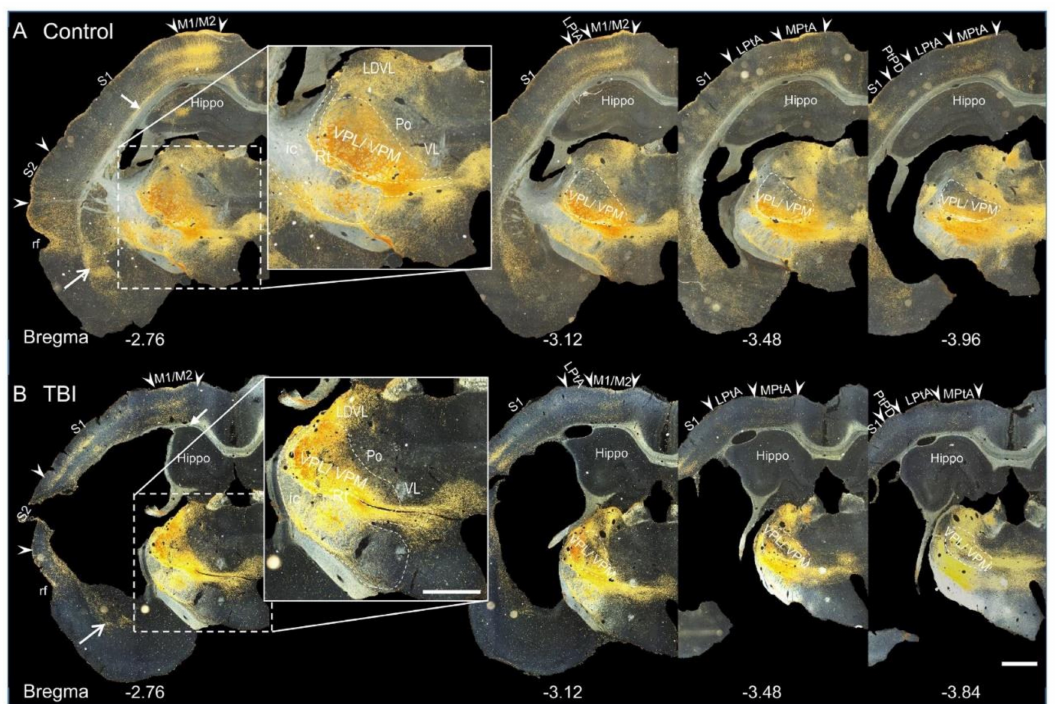
Figure 1. Darkfield photomicrographs demonstrating the distribution of ChR2-eYFP expression in CAMKII neurons (CaMKII-eYFP) in the thalamus of a control and traumatic brain injured (TBI) rat at 3 months after viral transduction. ( A ) ChR2-eYFP expression in a sham-injured (control) rat. ChR2-eYFP expression is revealed here as eYFP-positive immunolabeling (golden yellow color). ChR2-eYFP expression is observed in the thalamus, cortex, amygdala (open arrow), internal capsule (ic), external capsule (ec), and corpus callosum (cc) (closed arrow). The most intense ChR2-eYFP expression is in the targeted VPM and VPL thalamic nuclei. Note the ChR2-eYFP expression in the adjacent thalamic nuclei (insert), such as the laterodorsal thalamic nucleus (LDVL), post thalamic nuclear group (Po), and ventral thalamic nucleus (VL). ( B ) Darkfield image of ChR2-eYFP expression in a TBI animal. The thalamic expression pattern is comparable to that in controls (compare with panel A). Abbreviations: Hippo, hippocampus, ic, internal capsule; LPtA, lateral parietal association cortex; M1, primary motor cortex; M2, secondary motor cortex; Po, posterior thalamic nuclear group; Rt, reticular nucleus; S1, primary somatosensory cortex; S2, secondary somatosensory cortex; VPL, ventral posteromedial thalamic nucleus; VPM, ventral posterolateral thalamic nucleus. Scale bars in A, B, and the insert equals 1 mm.